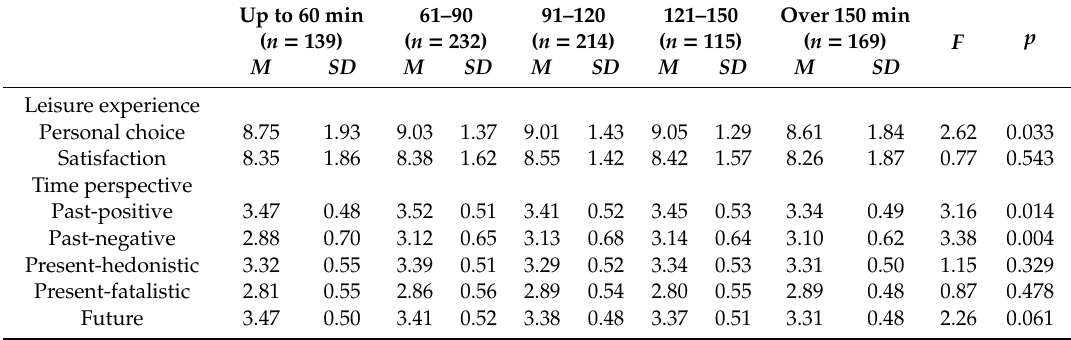
Table 4. Perceived experience of leisure activities and time perspective factors according to time